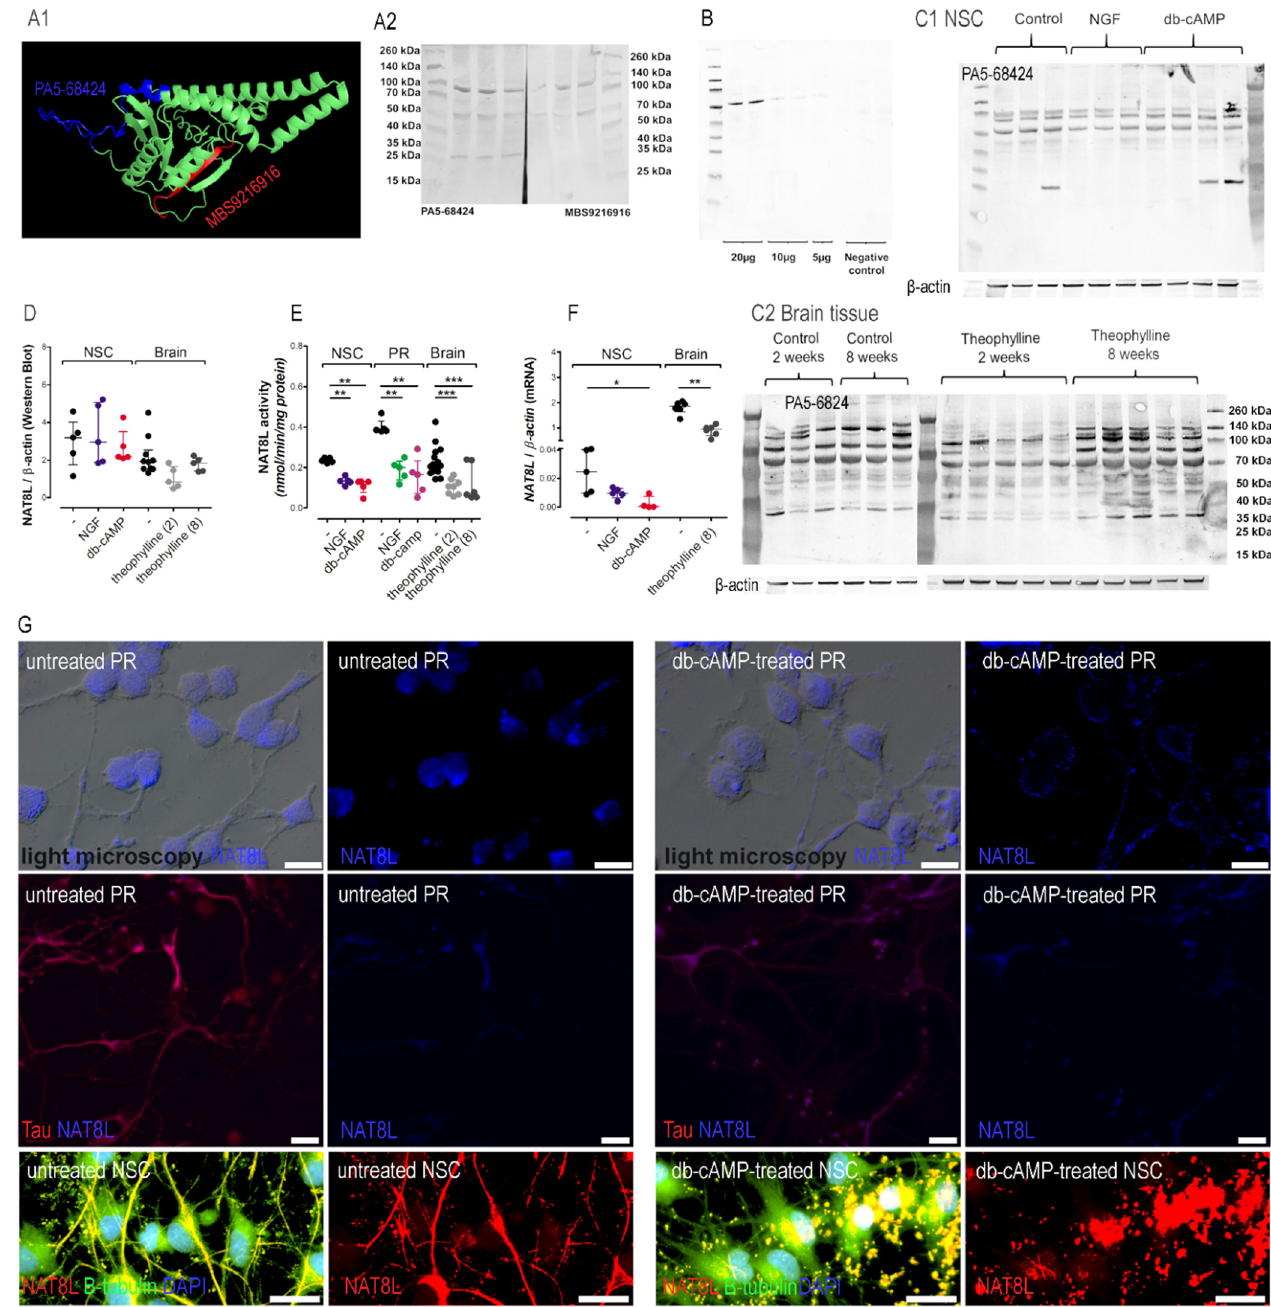
Figure 7. Impact of the maturation processes on the NAT8L. NAT8L tagged by PA5-68424 or MBS9216916 antibodies ( A1 ) NAT8L predicted structure (PDB ID: AF-Q8N9F0-F1) with marked epitopes. Illustrations edited as per author’s permis- sion statement, available under a CC-BY-4.0 License; ( A2 ) WB membrane images of brain homogenates; ( B ) representative WB membrane images of brain homogenates or skin tissue (negative control), NAT8L tagged by PA5-68424 antibody, ( C ) representative WB membrane images of NSC ( C1 ) and brain homogenates ( C2 ), NAT8L tagged by PA5-68424, β -actin was used as a reference protein; ( D ) NAT8L protein level calculated from WB membrane, band: 36 kDa; ( E ) NAT8L activity; ( G ) Nat8l mRNA level (RT-qPCR); ( H ) fluorescence microscopy of primary neurons (PR) and neural stem cells (NSC), white scale bar represents 20 µm, images are representative for 3 independent experiments. Results are showed as medians with interquartile ranges from 4–15 observations per group. Significantly different from the control: * ( p -value < 0.05), ** ( p -value < 0.01), *** ( p -value < 0.001). Abbreviations: NSC: neural stem cells; PR: primary neurons.